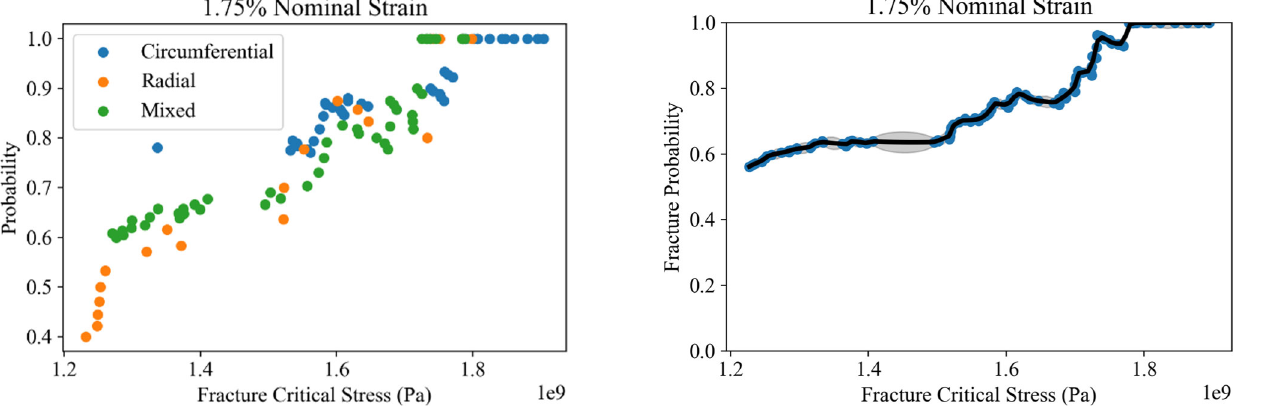
Fig. 6 Bayesian crack probability analysis for 1.75% nominal strain.